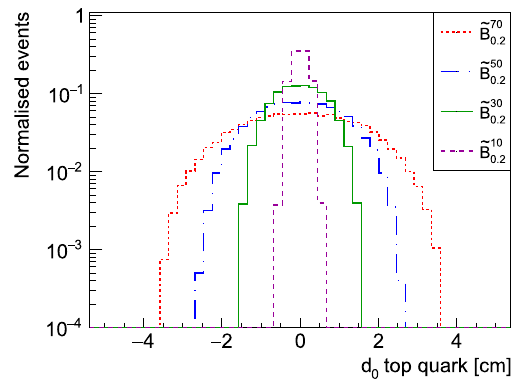
Fig. 9 Transverse momentum p T of the leading muon of the event in the ˜ B -like case